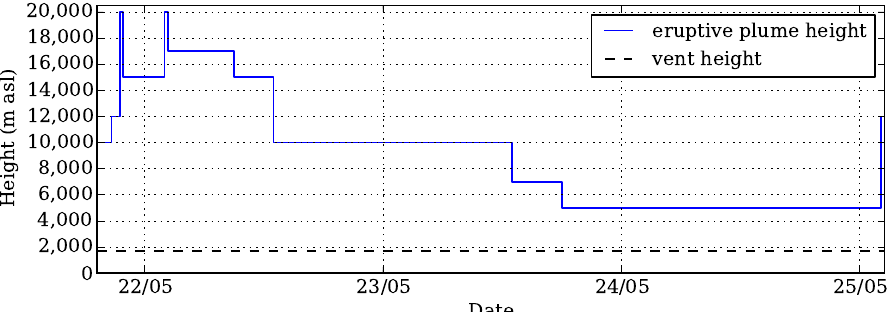
Figure 7. Grímsvötn 2011 eruption plume rise heights estimated from local